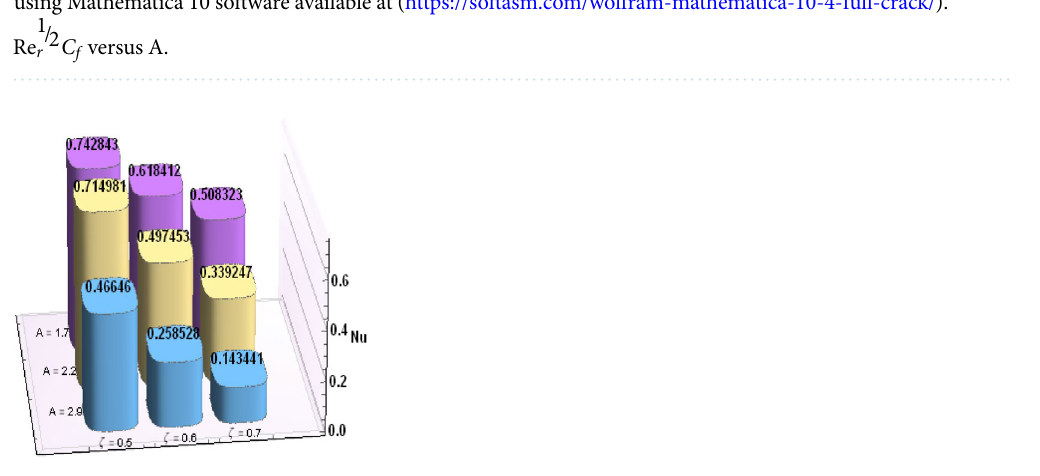
Figure 16. Bar chart representation of Skin friction coefficient and Nusselt number for different parameters using Mathematica 10 software available at (https:// softa sm. com/ wolfr am- mathe matica- 10-4- full- crack/). Nu versus A.